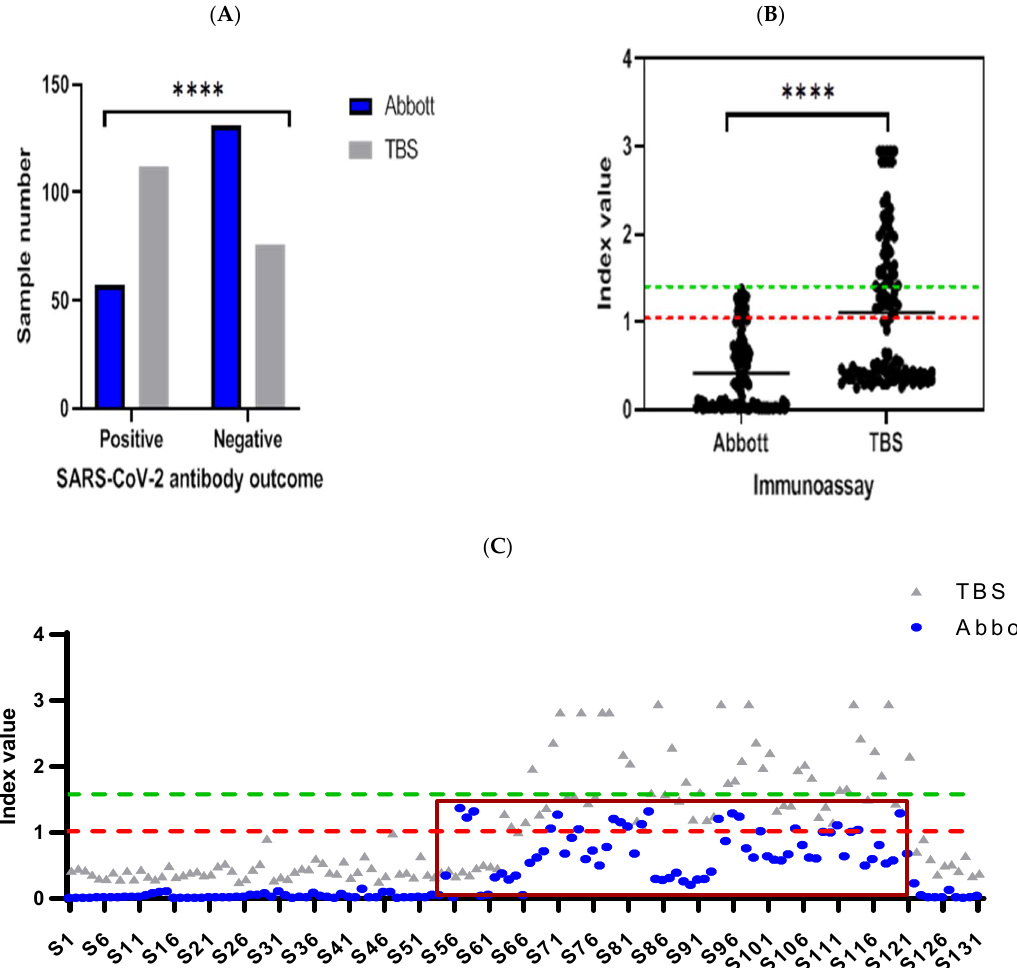
Figure 1. Comparative evaluation between Abbott and TBS, which detect antibody responses against SARS-CoV-2 nucle- ocapsid and spike, respectively. Results are presented as ( A ) bar graph, which compares positive and negative SARS-CoV- 2 antibody outcomes in 188 samples analysed between Abbott and TBS. Statistically significant differences for positive versus negative outcomes derived from both assays (**** = p < 0.0001, Fisher’s exact test). Nested scatterplot is presented by ( B ), which portrays the difference in outcomes produced by TBS in analysis of 131 samples deemed negative by Abbott (green dashed line = cut-off for Abbott (1.40 index value)). Of TBS outcomes, 45% were positive (red dashed line = cut-off for TBS (1.0 index value)) and above TBS mean index value (1.06, 95% CI: 0.92–1.20), which was significantly higher com- pared to TBS (0.36 index value, 95% CI: 0.31–0.46, **** = p < 0.0001, one sample t -test). Paired index values derived from negative sample analysis, from Abbott and TBS, are presented on the scatterplot in ( C ). Discrepant results from Abbott (blue dots) are categorised within the brown rectangular box (n = 59, index values; 0.26–1.31), where reciprocal analysis by TBS (grey triangles) was deemed positive in all 59 samples. The x-axis represents sample identity (S1 = sample 1) de- rived from individuals for analysis in Abbott and TBS.